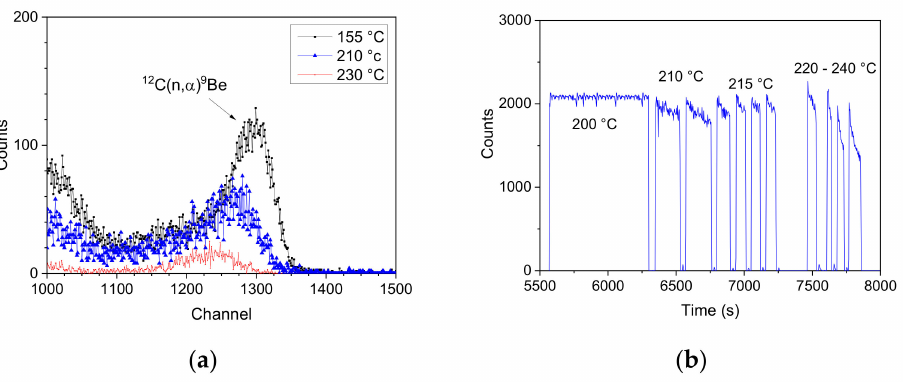
Figure 23. ( a ) Temperature-dependent 12 C(n, α 0 ) 9 Be peak position as recorded for a 500 μ m thick diamond with two Pt metal contacts; ( b ) counting rate versus irradiation time and temperature.